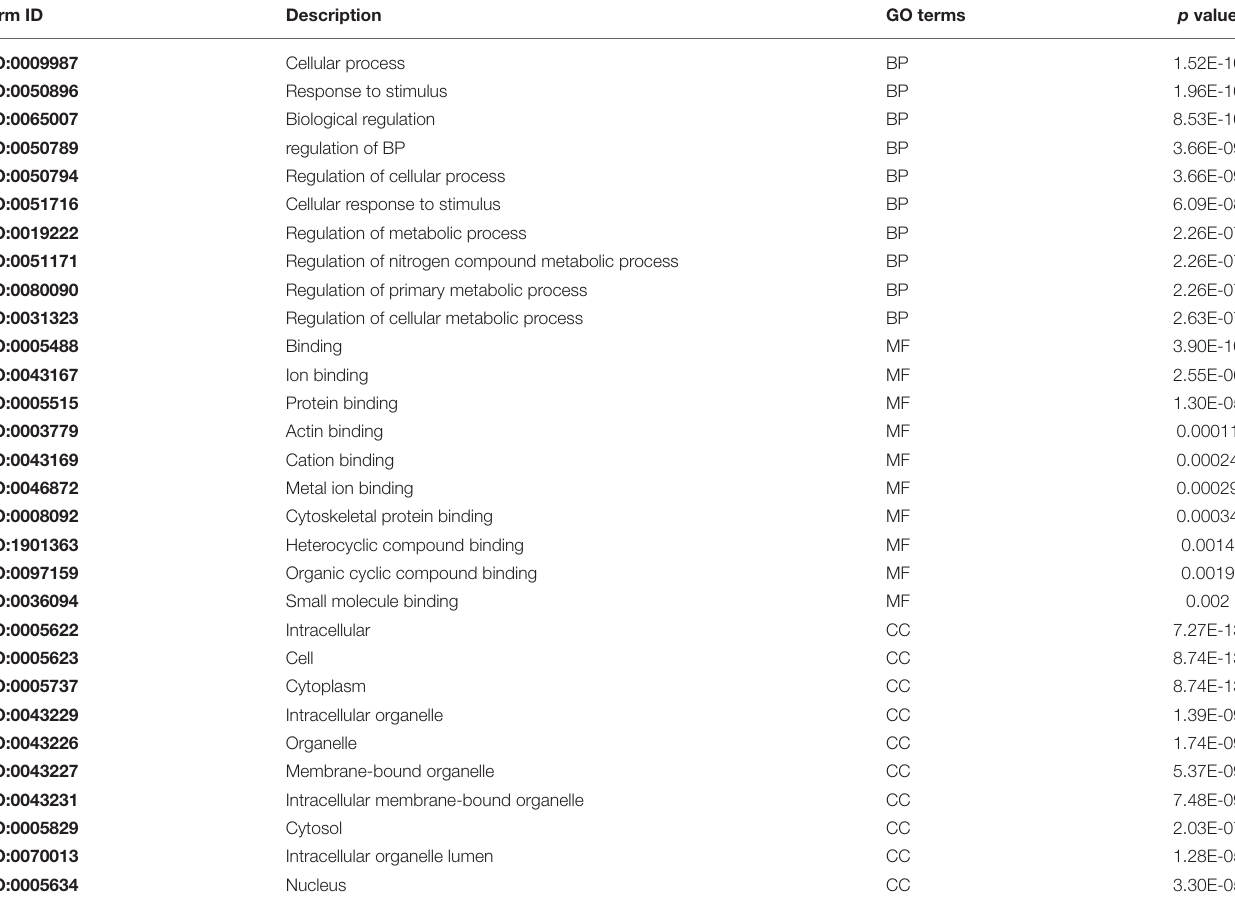
TABLE 3 | Significant GO terms of common genes.